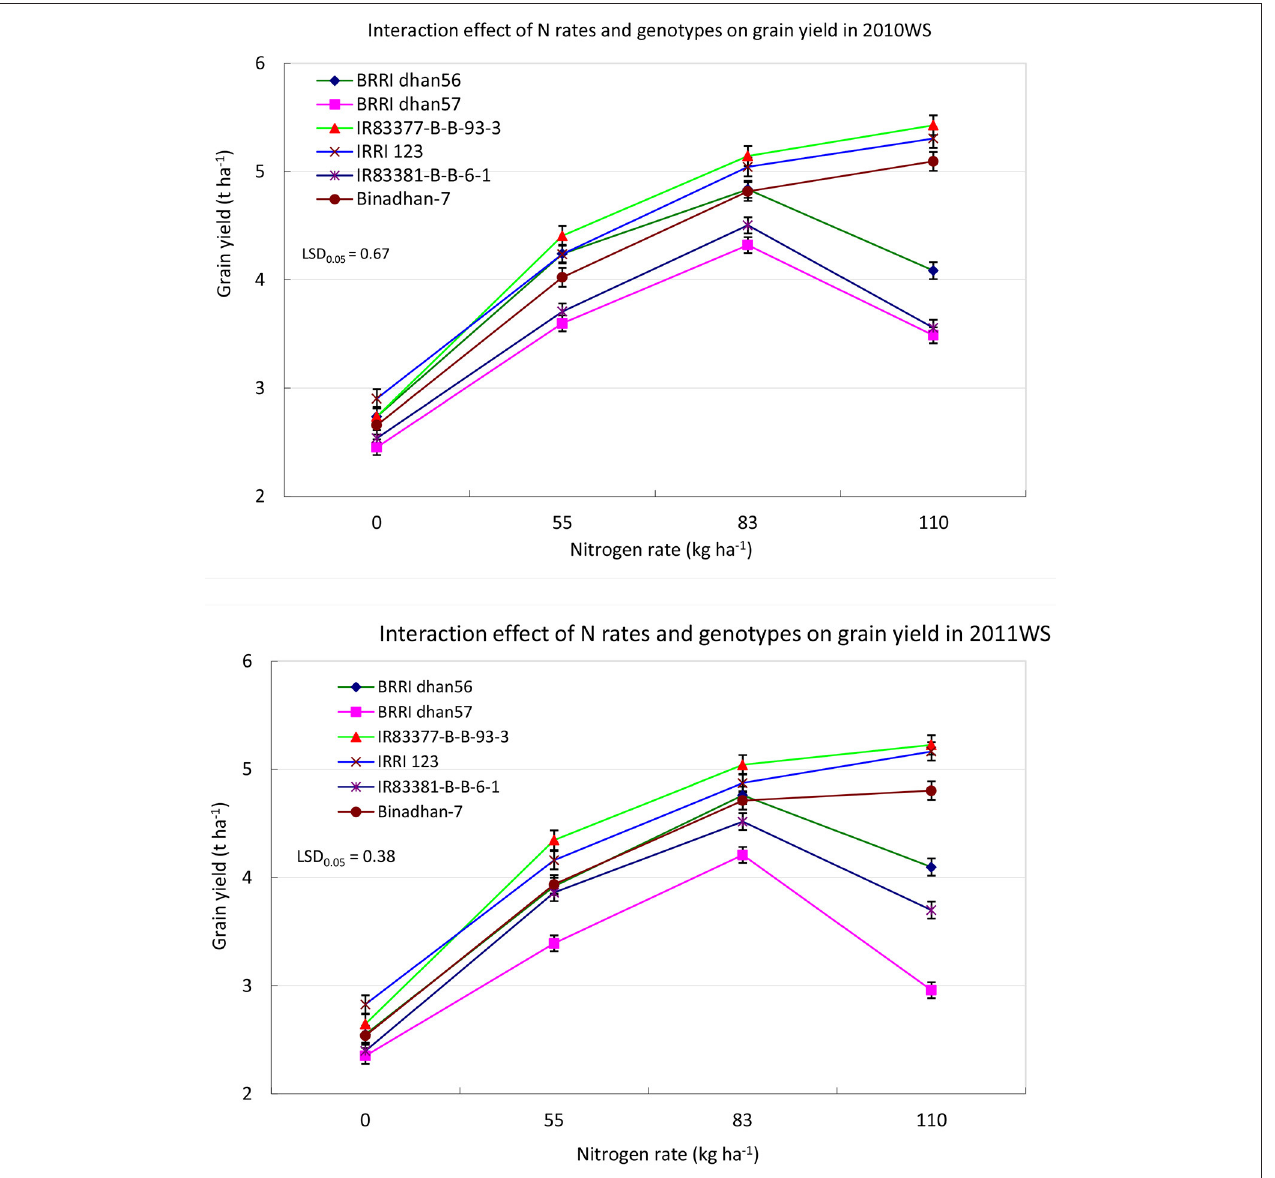
FIGURE 5 | Interaction of genotypes and N rates on grain yield of the rice genotypes during 2010WS and 2011WS. Bars indicate the standard error of the